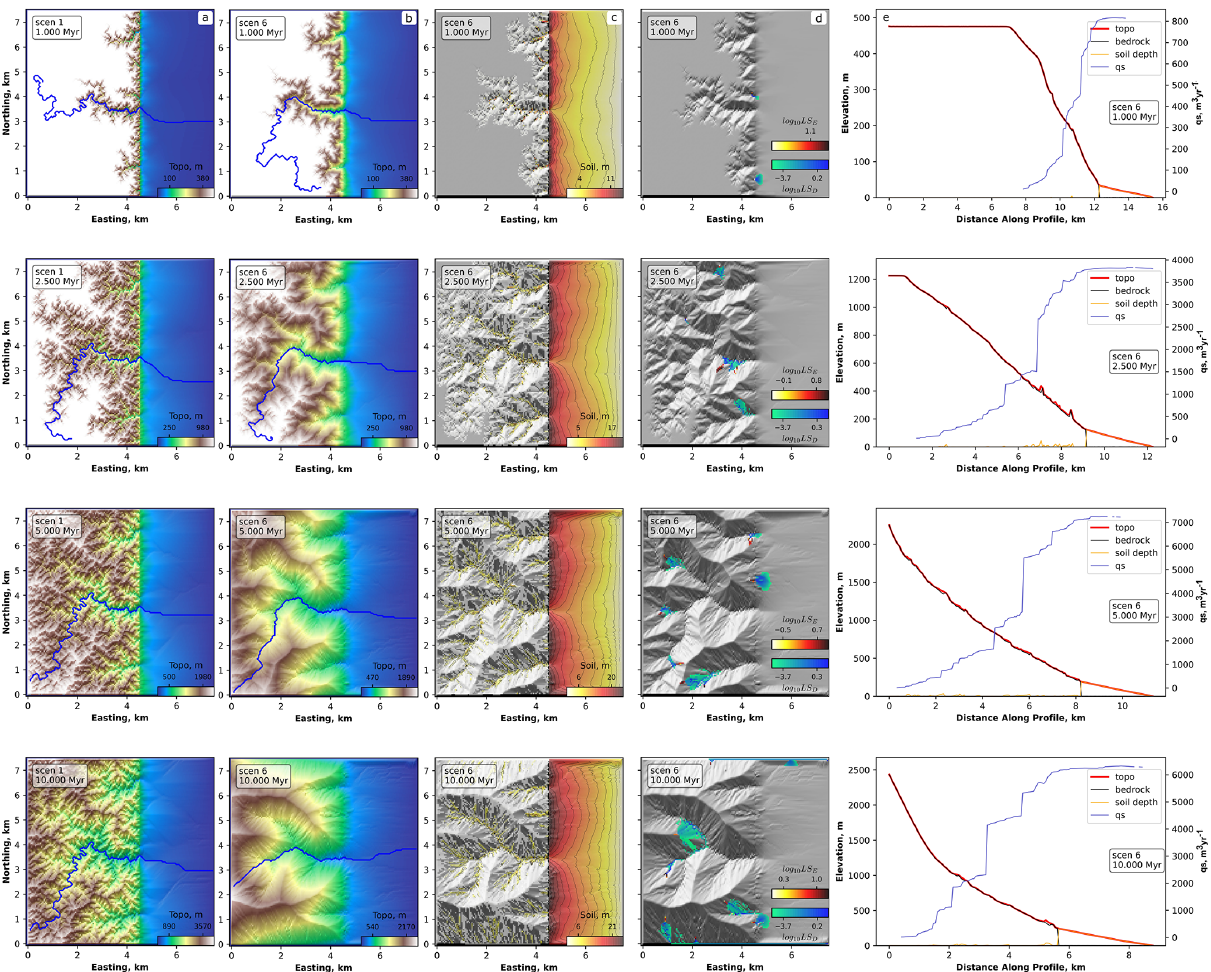
Figure 13. Illustration of HyLands model component. (a) Time slices showing evolution of the landscape to steady state without landsliding. The blue lines represent the plan-view locations of rivers plotted in the right-hand column. Column (b) is the same as column (a) but with landsliding. (c) Sediment accumulation and the formation of alluvial fans (with landsliding). (d) Landslide activity during the depicted time step. Red colors represent the logarithm of the landslide erosion depth; blue colors represent deposition. Column (e) shows the topographic and bedrock elevation (red and black line, respectively) and the sediment thickness (orange line). The sediment flux is plotted against the right-hand y axis (blue line). Note that during landsliding both pure landslide dams (red bumps on the profile) and irregularities in the bedrock profile (grey bumps) arise. The latter originate from the river being redirected after landsliding, forming epigenetic